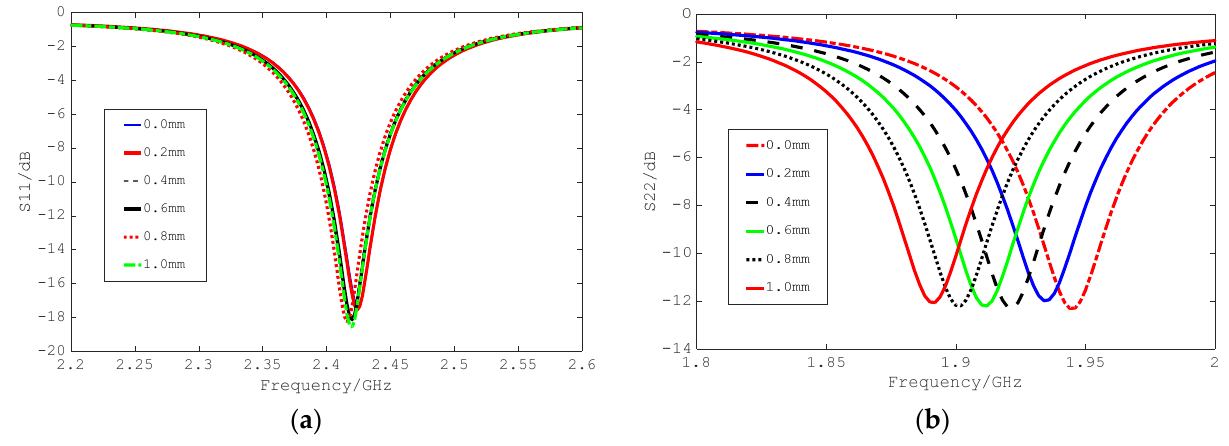
Figure 8. Simulated reflection coefficients of designed sensor for vertical crack with different widths. ( a ) Port 1. ( b ) Port 2.